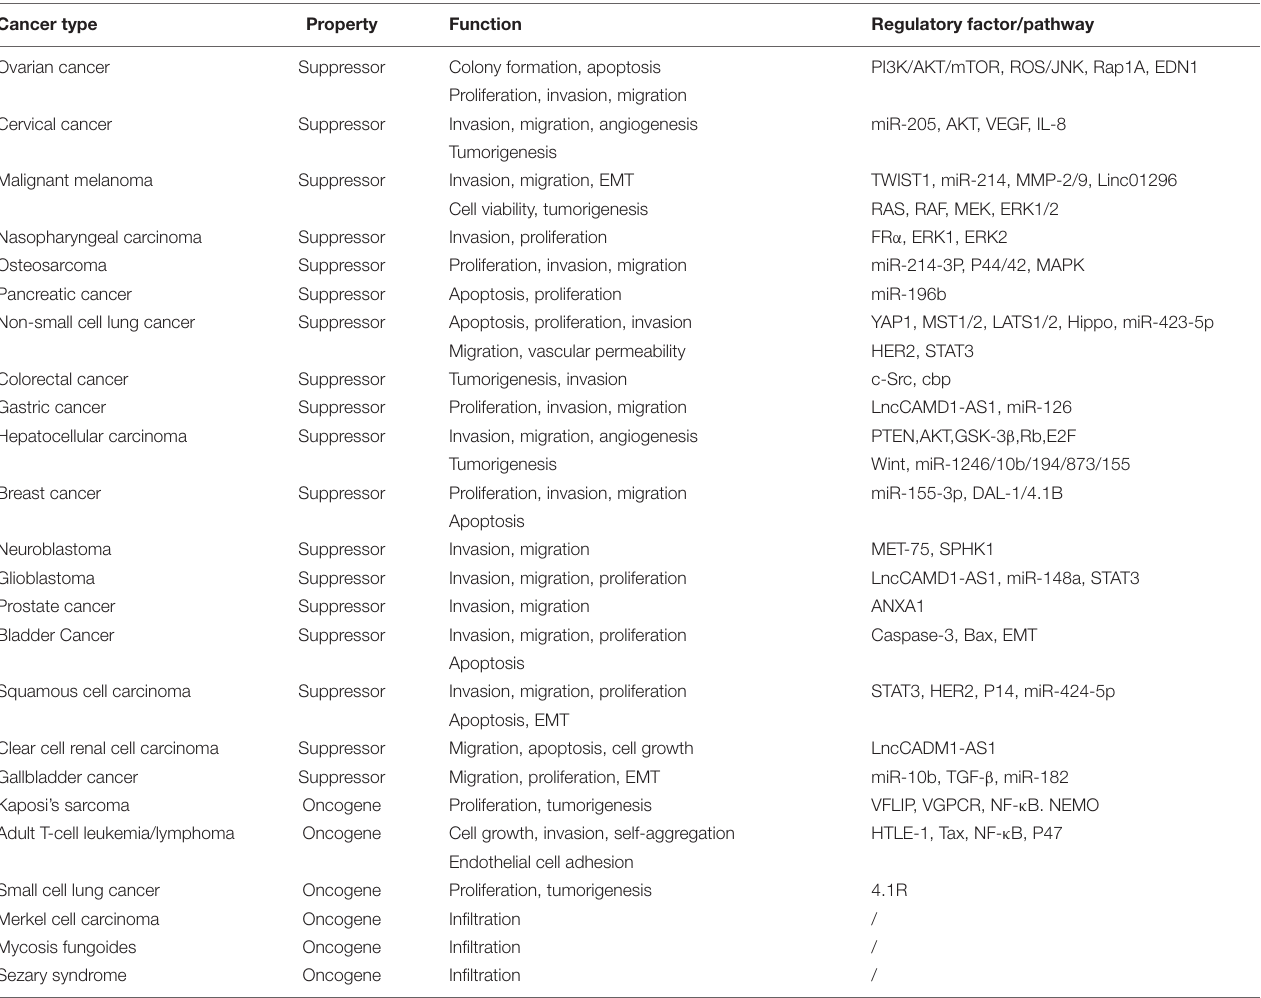
TABLE 2 | Summary of the function and regulatory factor/pathway for CADM1 in cutaneous malignancies.